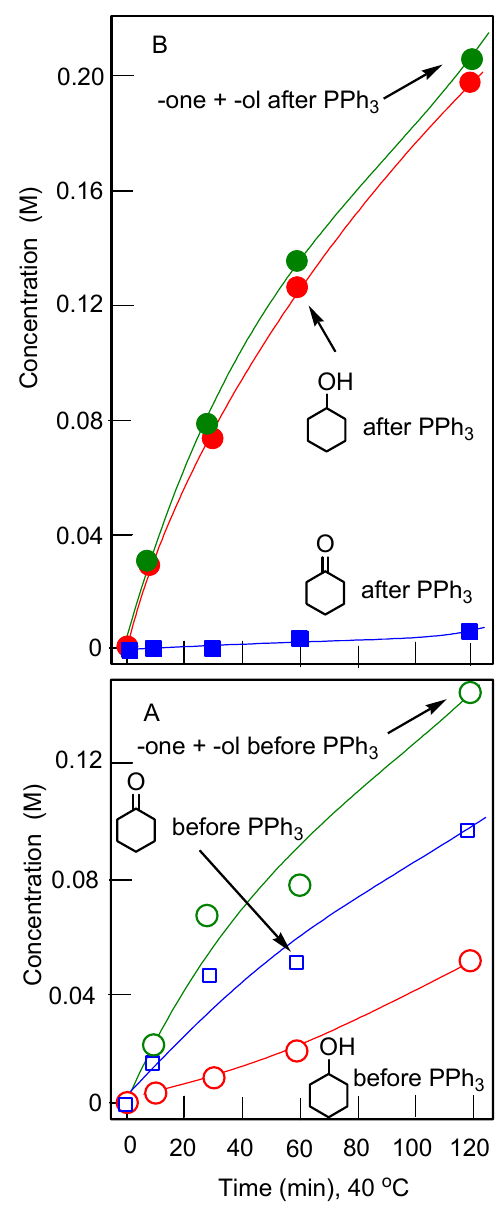
Figure 10. Accumulation of cyclohexanol and cyclohexanone with time in the cyclohexane (0.45 M) oxidation with H 2 O 2 (50%, aqueous, 1.5 M) catalyzed by compound 15 (5 × 10 ‒ 4 M) in the presence of CF 3 COOH (0.05 M). Solvent was acetonitrile (total volume of the reaction solution was 5 mL); temperature was 40 °C. Concentrations measured before (Graph A ) and after (Graph B ) reduction of the samples with PPh 3 are shown.